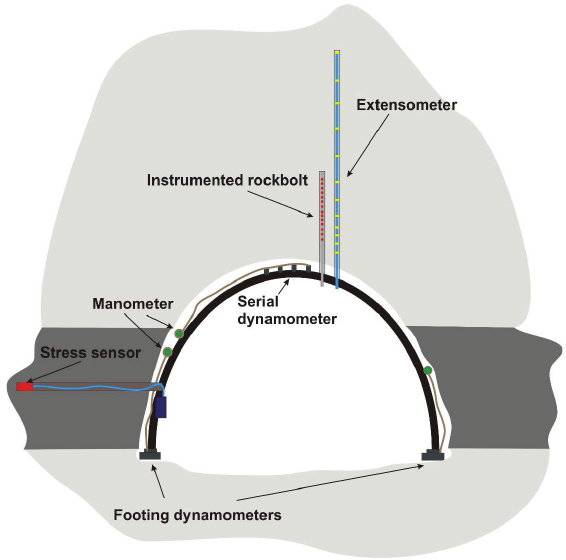
Fig. 1. Overall scheme of the measurement station Figure 1: Overall scheme of the measurement